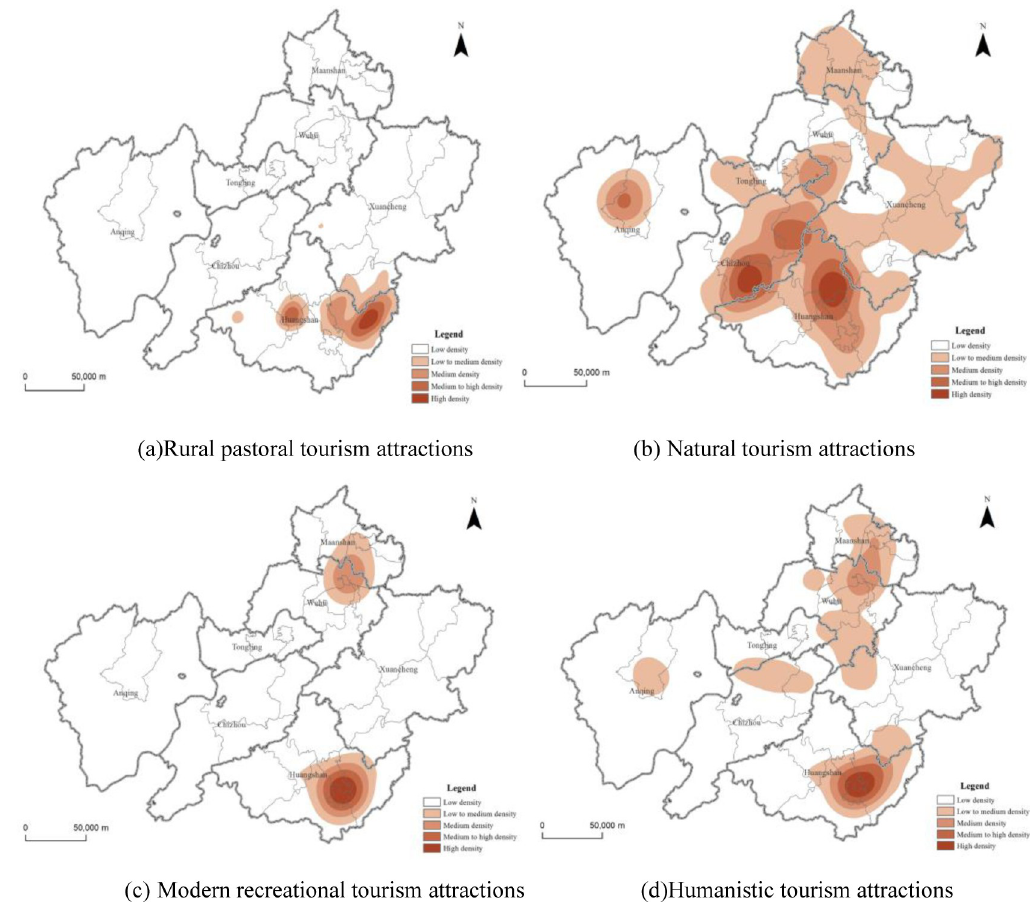
Fig 3. The hot spot distribution characteristics of tourist attractions in the demonstration region. Contains information from OpenStreetMap and OpenStreetMap Foundation, which is made available under the Open Database License. (a) Rural pastoral tourism attractions. (b) Natural tourism attractions. (c) Modern recreational tourism attractions. (d) Humanistic tourism attractions.